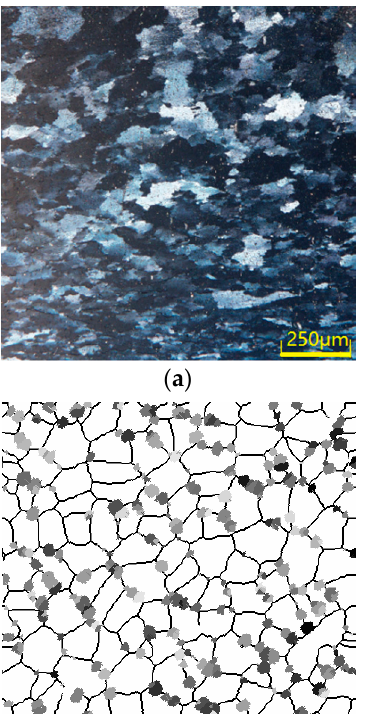
Figure 7. The initial microstructure of the 5754 aluminium alloy.